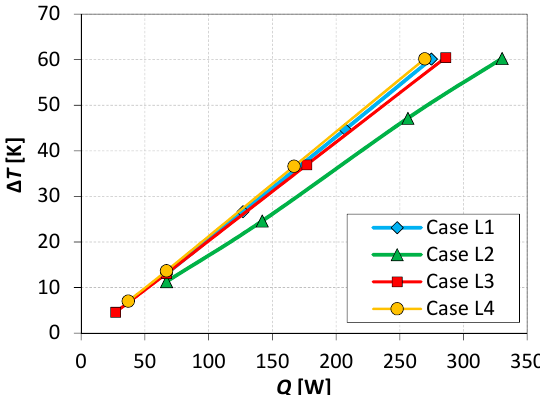
Figure 11. Heat sink temperature difference as a function of dissipated thermal power, P = 7.0 W, at individual resonance frequency.